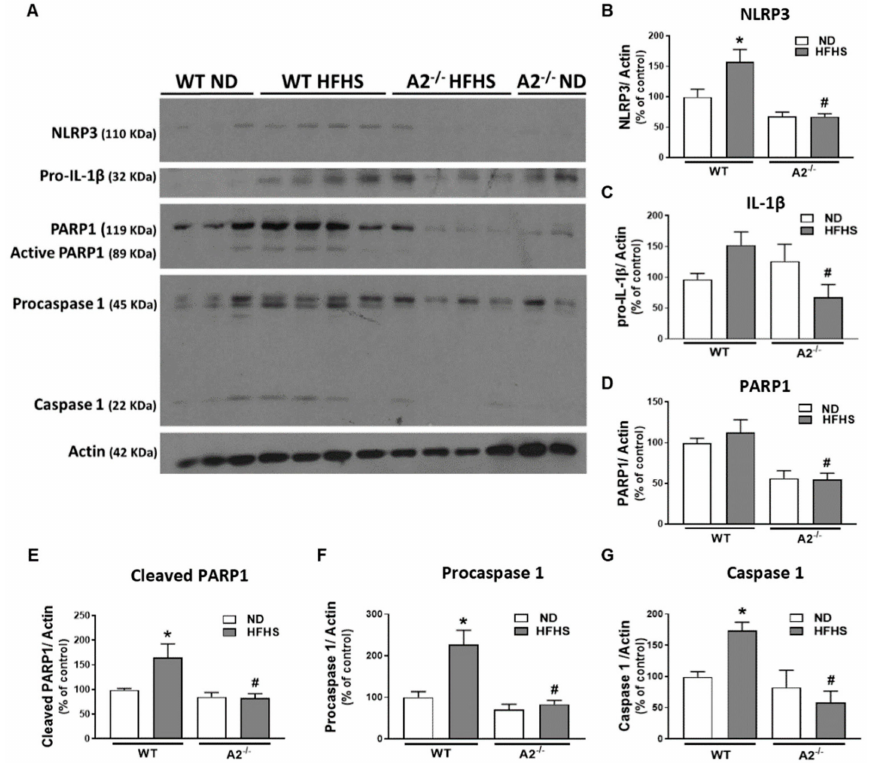
Figure 3. Arginase 2 (A2) deletion prevented high-fat, high-sucrose (HFHS) diet-induced inflammasome activation. Representative western blot ( A ) with quantitation showing the e ff ect of HFHS and